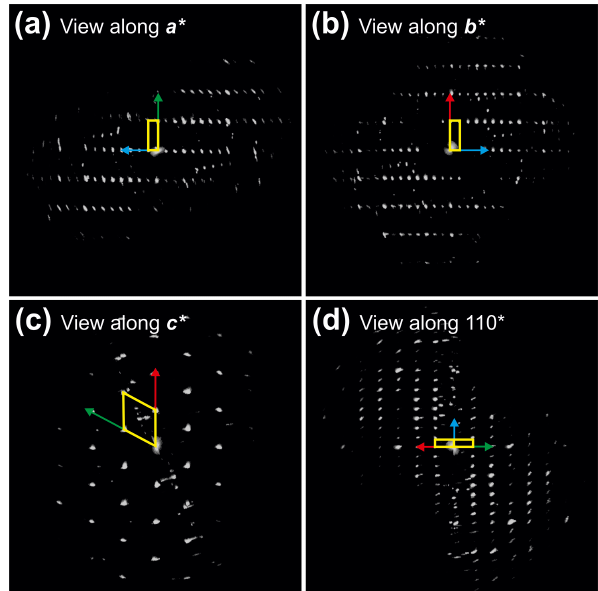
Figure 4. 3D reconstruction of electron diffraction data taken from badengzhuite (TiP) at point no. 426 (Fig. 3c). (a) View along 100 ∗ . Reflections belonging to a second crystalline individual, proba- bly the hosting zhiqinite (TiSi 2 ) domain, were occasionally sam- pled and therefore appear in the 3D reconstruction. (b) View along 010 ∗ . (c) View along 001 ∗ . (d) View along 110 ∗ . Extinction rule hh 2 hl : l = 2 n is not evident in projection due to the occurrence of extra reflections not belonging to the badengzhuite (TiP) domain. Cell edges are sketched in yellow. Red arrow indicates a ∗ direc- tion, green arrow indicates b ∗ direction and blue vector indicates c ∗